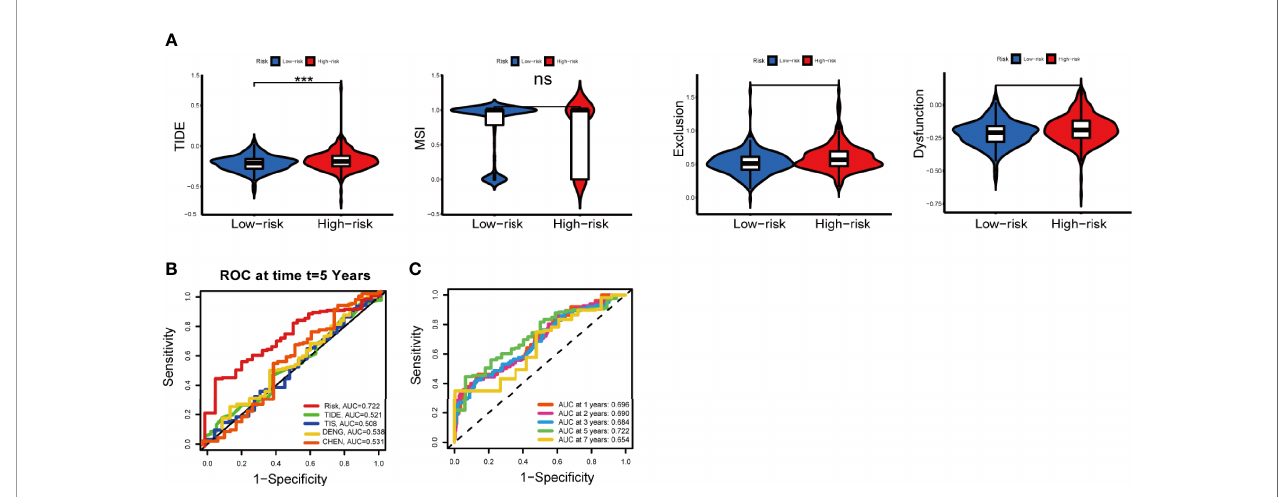
FIGURE 8 | Immune response to ICI therapy and the prognostic value. (A) TIDE, MSI, and T cell exclusion and dysfunction score for different IRGPI groups. Scores were compared between the two IRGPI groups (ns, not signi fi cant; *** P < 0.001). (B) Kaplan-Meier survival analysis of the IRGPI groups in TIDE, TIS, the colon cancer cohorts of Deng et al. and Chen et al. (C) Time-dependent ROC curve analysis. ICI, immune checkpoint inhibitor; MSI, microsatellite instability; TIS, T cell- in fl amed signature; IRGPI, immune-related gene prognostic index; ROC, receiver operating